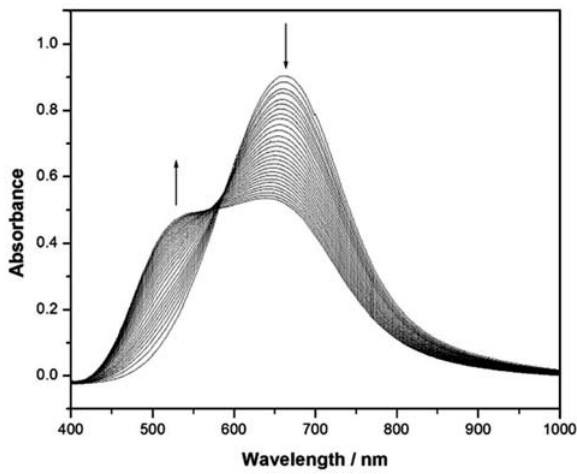
Fig. 6. Plot of the rate constant k botn (6.50 × 10 –3 M) complex .